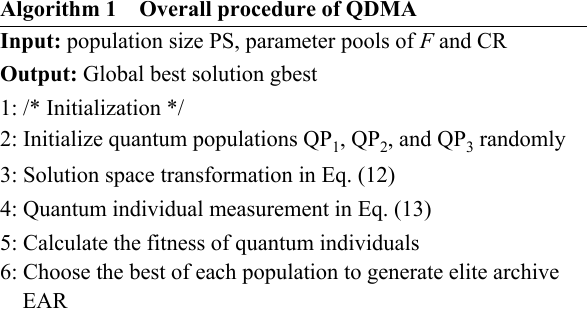
Algorithm 1 Overall procedure of